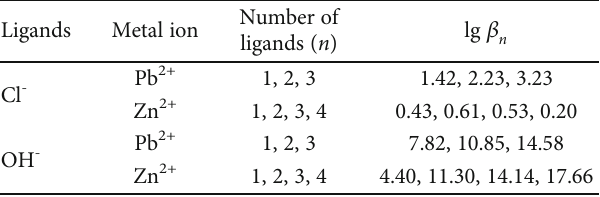
Table 2: Stability constants of metal inorganic complexes (25 ° C). Ligands